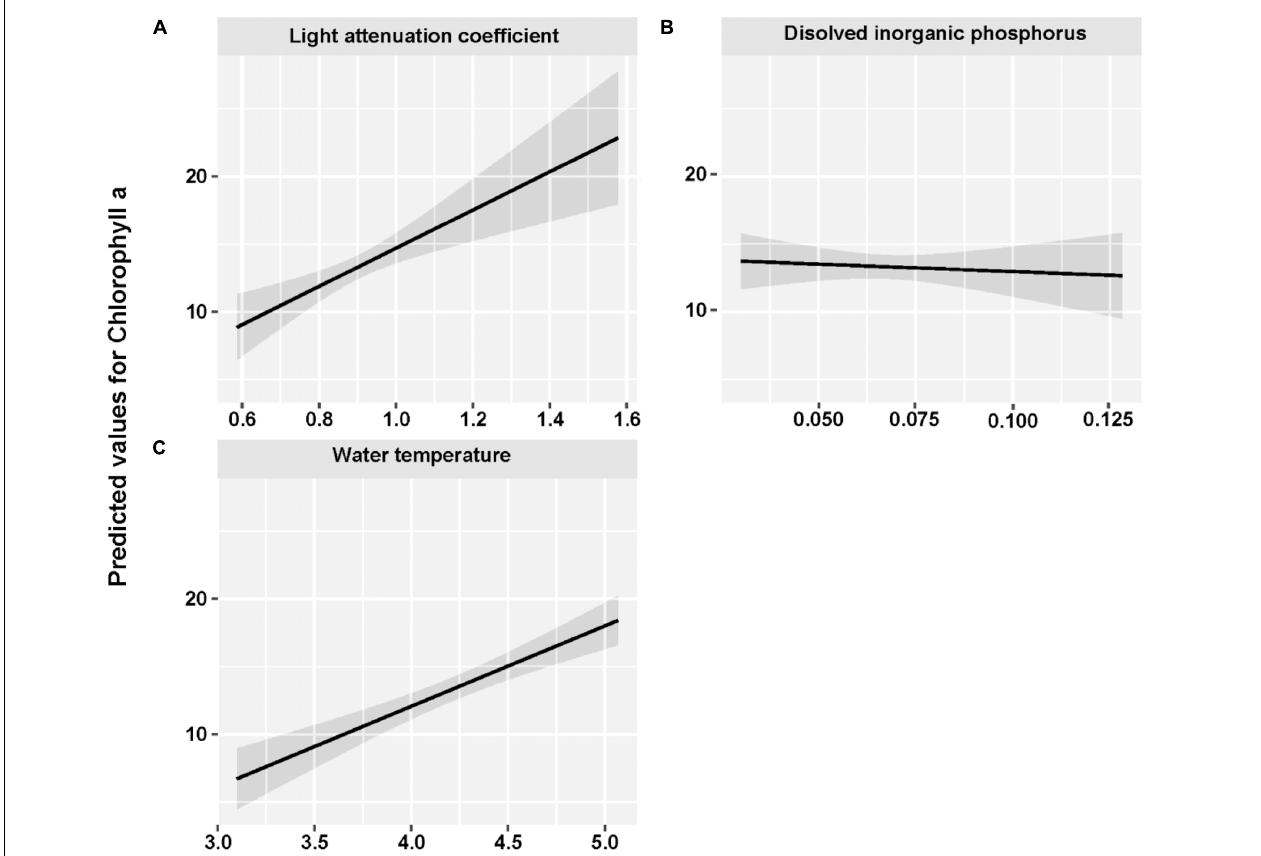
FIGURE 5 | Fitted light attenuation coefficient (A) , dissolved inorganic phosphorus (B) , and water temperature (C) for Chlorophyll a by using GLMMs analysis.